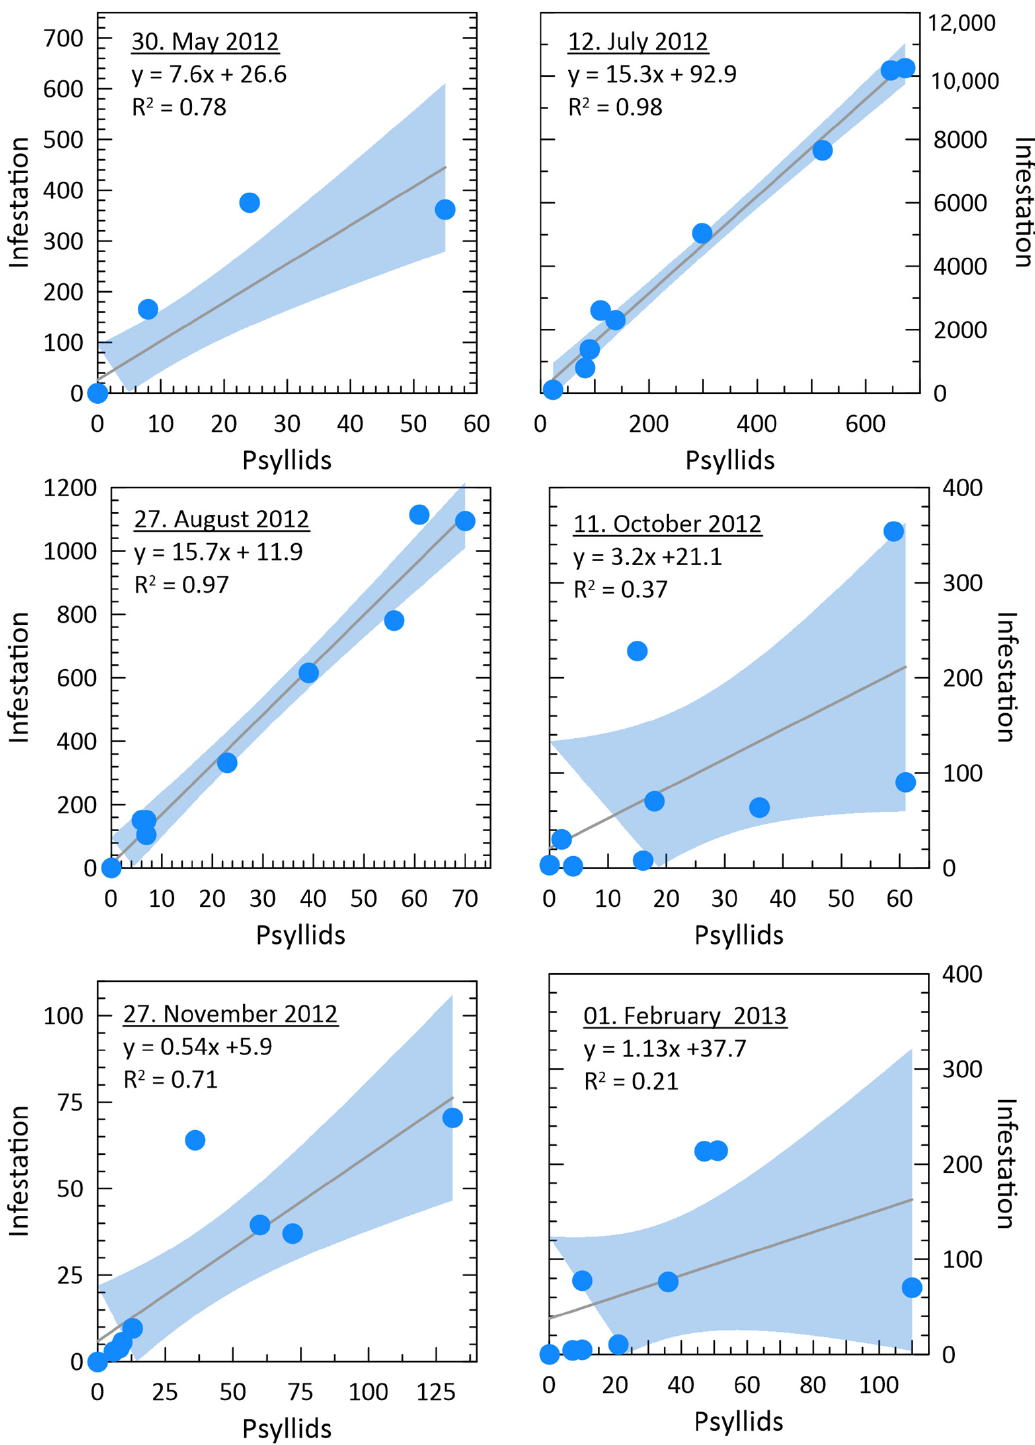
Figure 4. Scatterplots of data coming from psyllid and infestation sampling for all six sampling dates and all test sites (each blue dot represents one test side; blues shaded area (95% confidence interval)).